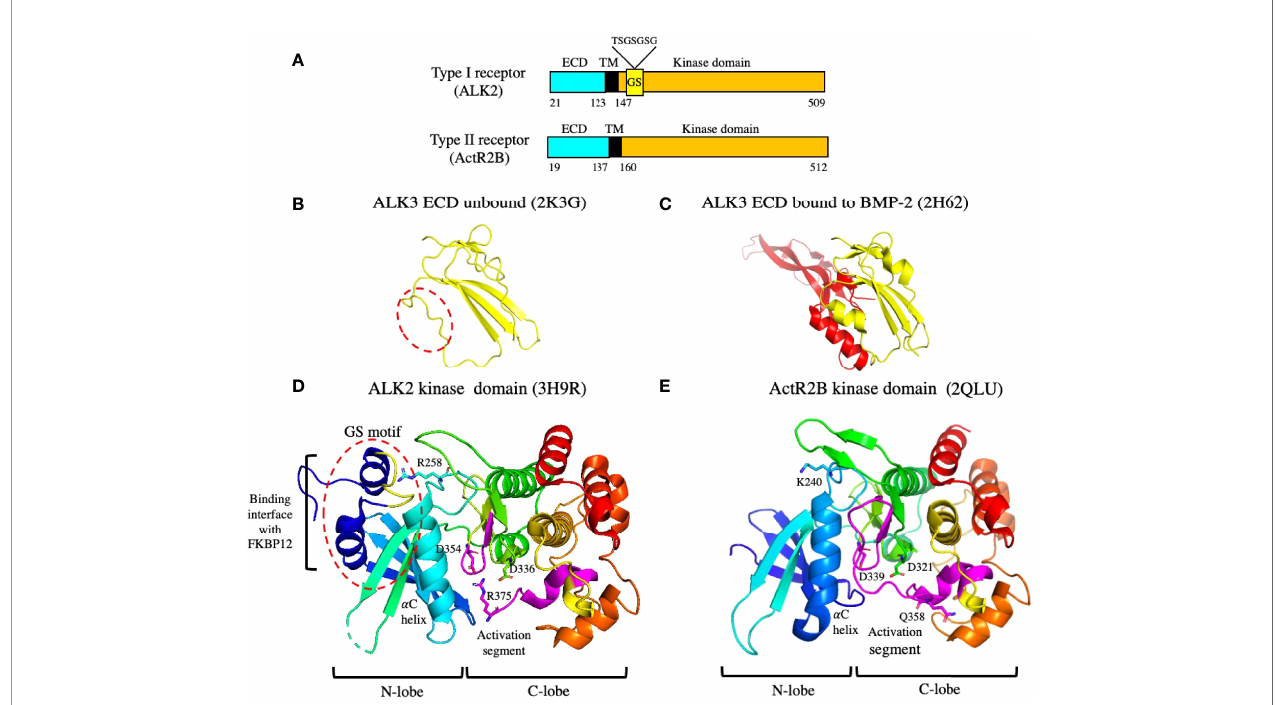
FIGURE 5 | Organization and structures of the type I and type II receptors. (A) A schematic diagram showing the organization of the type I and II receptors. The type I receptor contains a GS motif that is phosphorylated by the type II receptor on serine residues, leading to its activation. The amino acid sequence of the GS loop containing the serine residues that are phosphorylated is shown above the GS motif. The numbering corresponds to amino acid residues in UniProtKB accession numbers Q04771 (human ALK2) and Q13705 (human ActR2B). ECD: extracellular domain; TM: transmembrane. (B, C) Structures of the ALK3 ECD in solution (B) and bound to the BMP-2 ECD (C) . The dashed red oval shows that the alpha helix in ALK3 involved in binding BMP-2 is not present in the unbound state. (D, E) Structures of an inactive type I receptor kinase domain (ALK2) (D) and an active type II receptor kinase domain (ActR2B) (E) . The GS motif in ALK2 is indicated by the red dashed oval; it interacts with FKBP12 as shown. The GS motif is composed of two alpha helices connected by a loop (yellow) which contain the serine residues that are phosphorylated by the type II receptor. ALK2 contains a salt bridge between residue R375 and residues D336 and D354. Both aspartate residues are required in all kinases for Mg-ATP binding and catalysis. PDB fi les used to generate the structures are